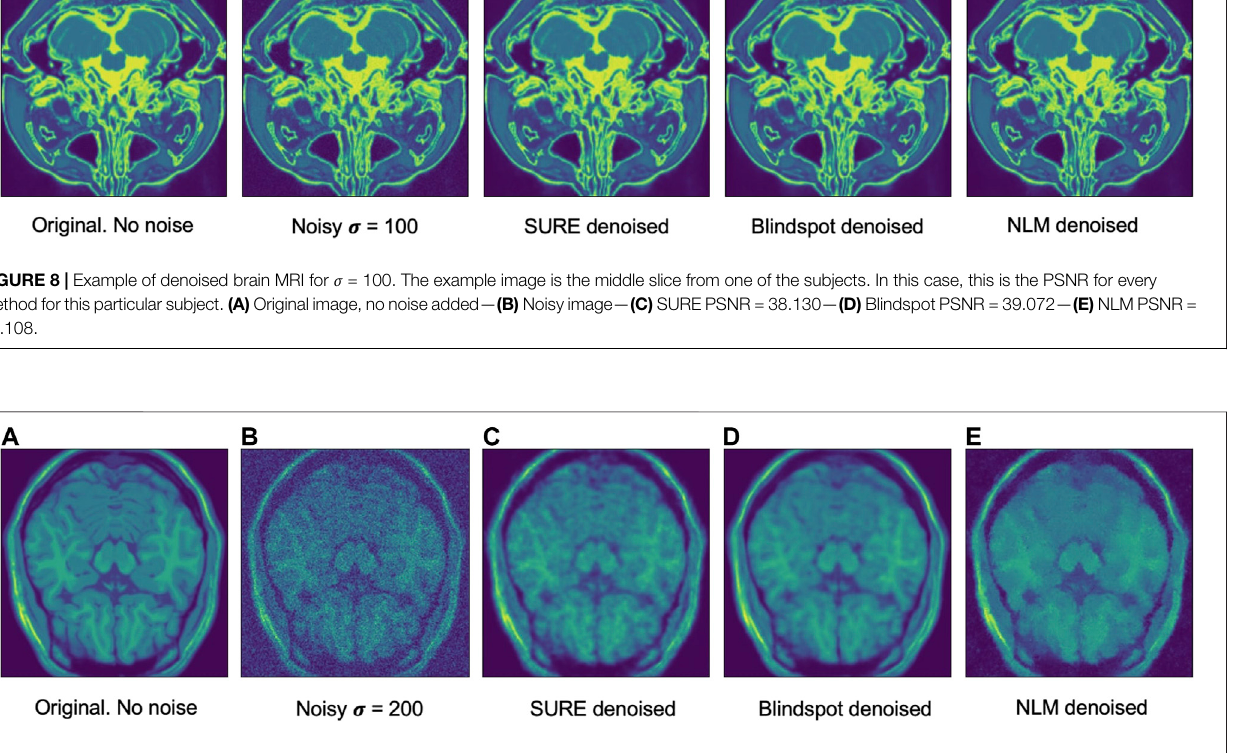
FIGURE 9 | Example of denoised brain MRI for σ (cid:1) 200. The example image is the middle slice from one of the subjects. In this case, this is the PSNR for every methodforthisparticular subject. (A) Originalimage, nonoiseadded — (B) Noisyimage — (C) SUREPSNR (cid:1) 29.610 — (D) BlindspotPSNR (cid:1) 30.904 — (E) NLMPSNR (cid:1) 26.616.